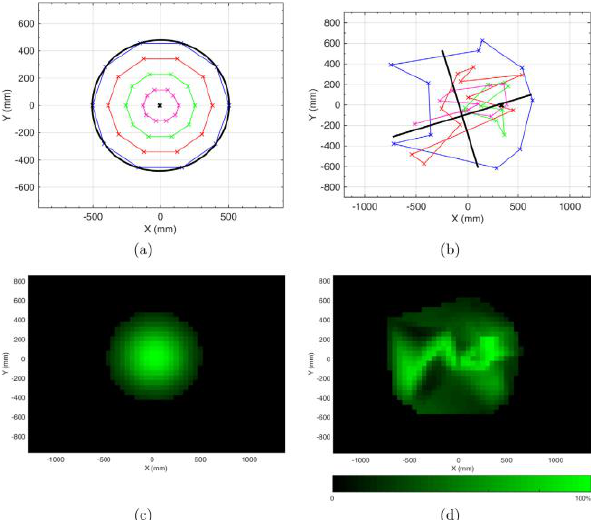
Figure 4: Wave-induced changes in laser spot size and shape on a simulated wave pattern – left water surface, right water bottom (Westfeld et al.,